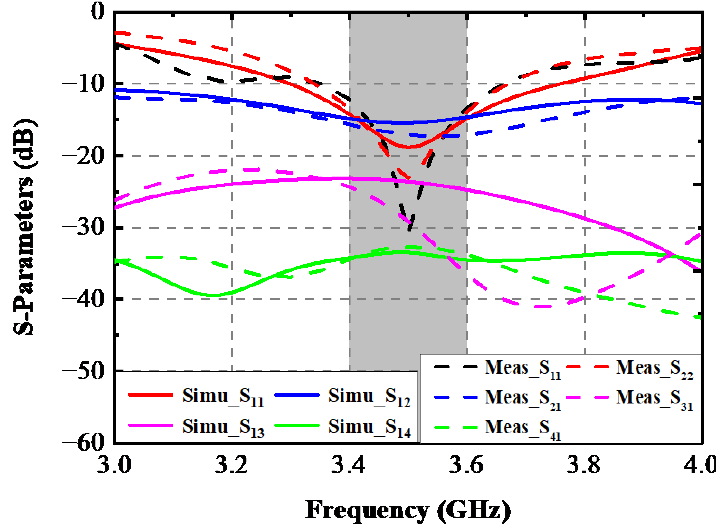
Figure 12. Measured and simulated S-parameters of the proposed AP system.